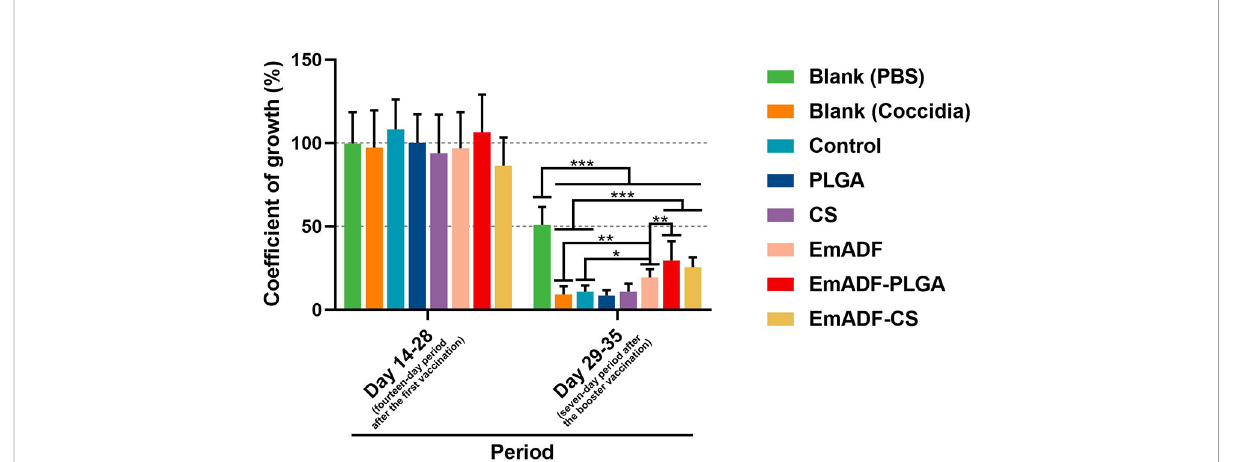
FIGURE 9 The coef fi cient of growth in immunized chickens. Each chicken was orally challenged with 5 × 10 4 puri fi ed E. mitis oocysts seven days after the second vaccination. Chickens were weighted at the age of 14, 28, and 35 days, and the coef fi cient of growth was calculated. Each group involved ten biological replicates, and each replication was detected once. Values were estimated using one-way ANOVA analysis followed by Dunnett ’ s test. Comparisons among EmADF, EmADF-PLGA, and EmADF-CS group were conducted by ANOVA following Bonferroni ’ s correction. Values were presented as the mean of the mean ± SD. * p< 0.05, ** p< 0.01, and *** p<